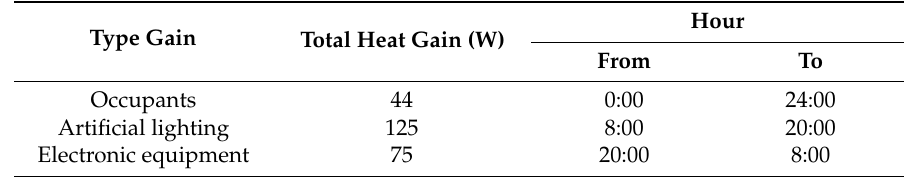
Table 3. Boundary conditions: the internal gains for zone. Hour Type Gain Total Heat Gain (W) From To Occupants 44 0:00 24:00 Artificial lighting 125 8:00 20:00 Electronic equipment 75 20:00 8:00